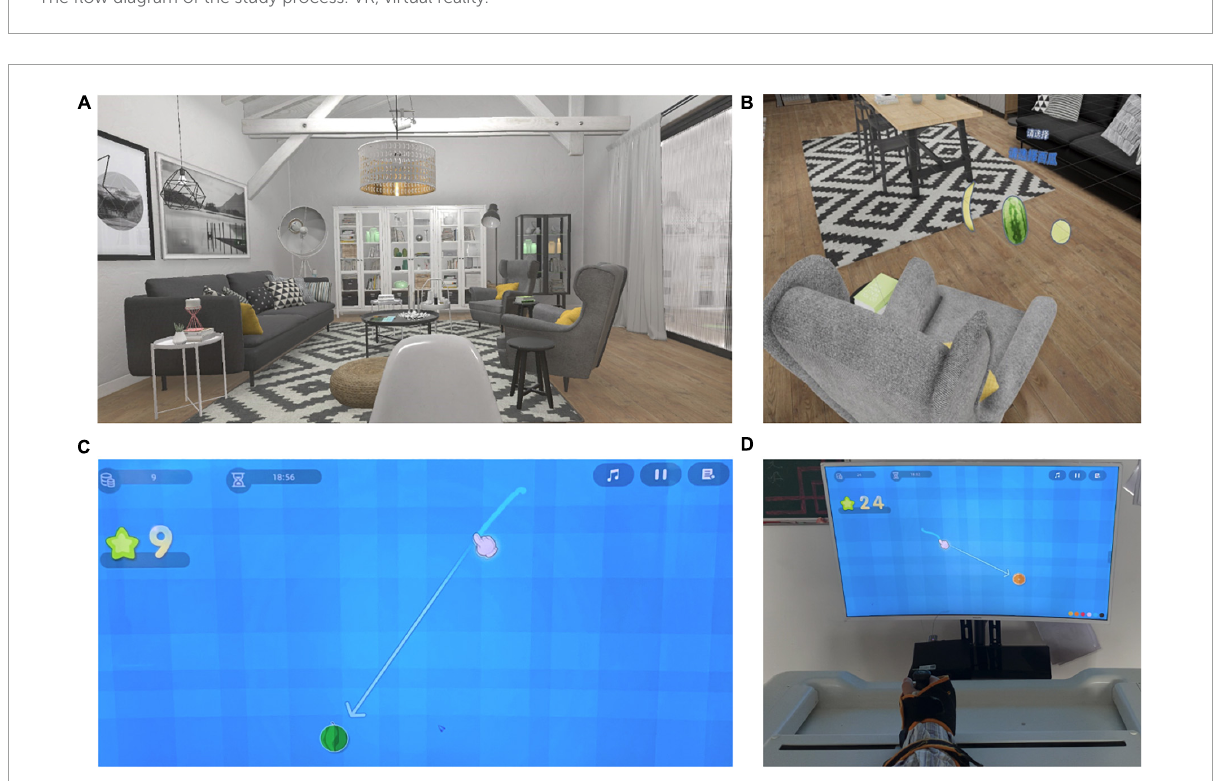
FIGURE2 The virtual reality (VR) training scenarios in the immersive-VR group and the control group. (A,B) The 3D virtual scenario shown through the VR helmet for immersive VR training in the immersive-VR group. (C,D) The 2D virtual scenario shown on the screen for VR training in the control